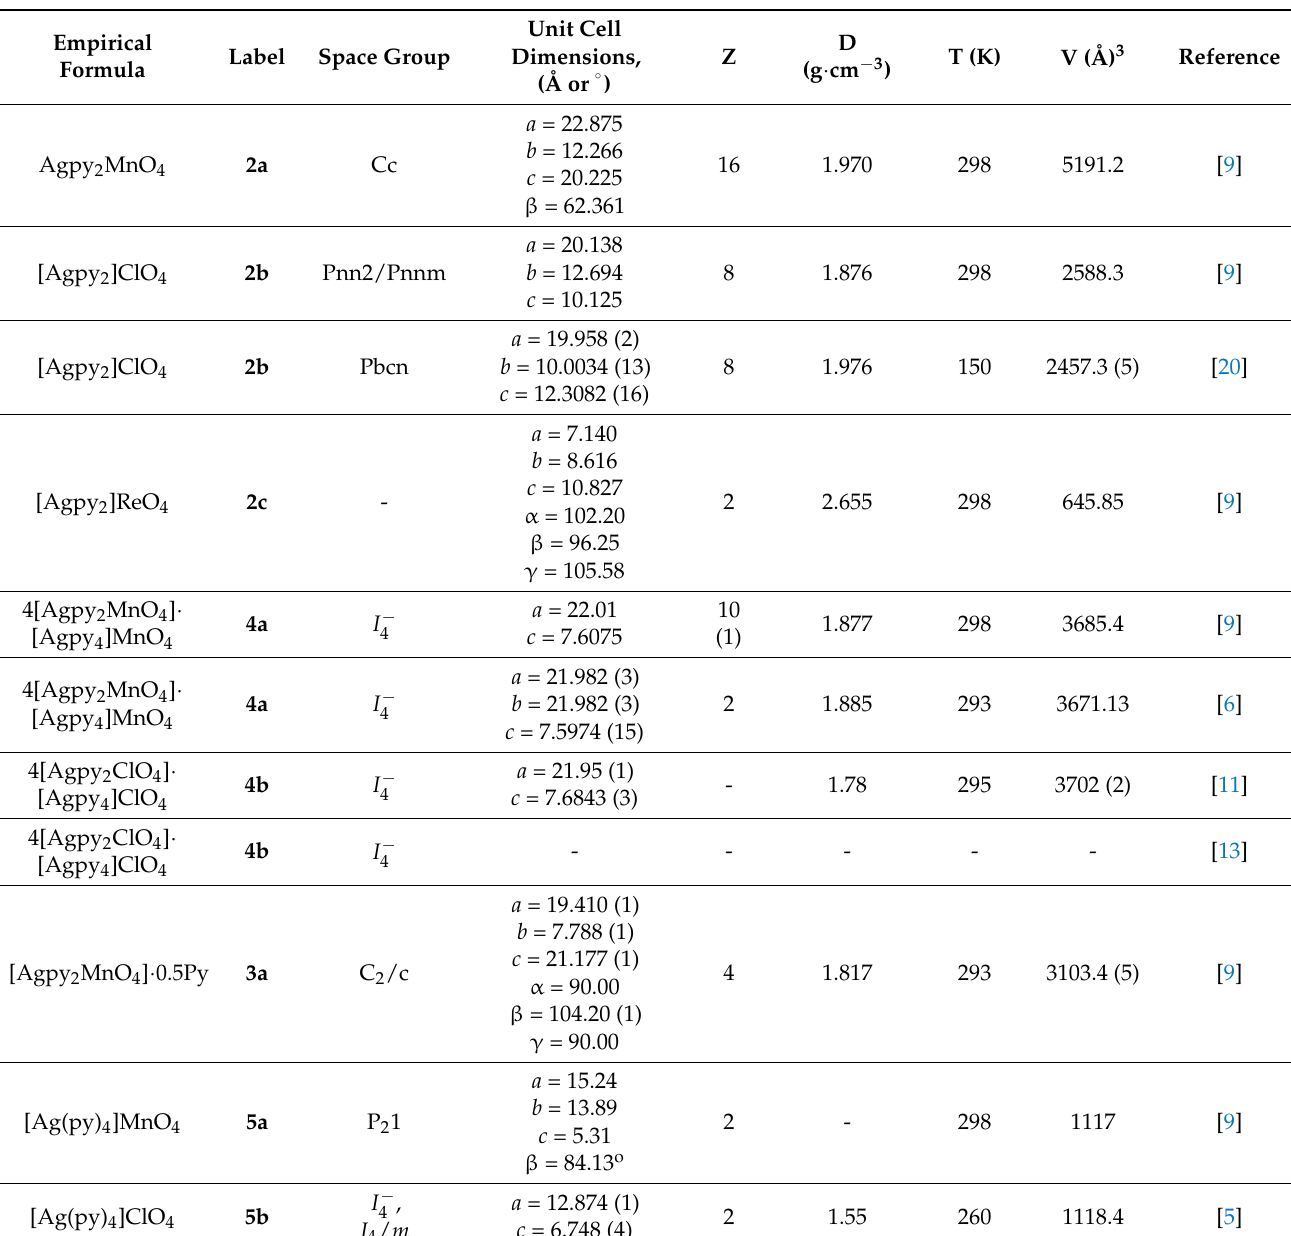
Table 2. Crystallographic parameters of Ag-Py-XO 4 (X = Mn, Cl, and Re)